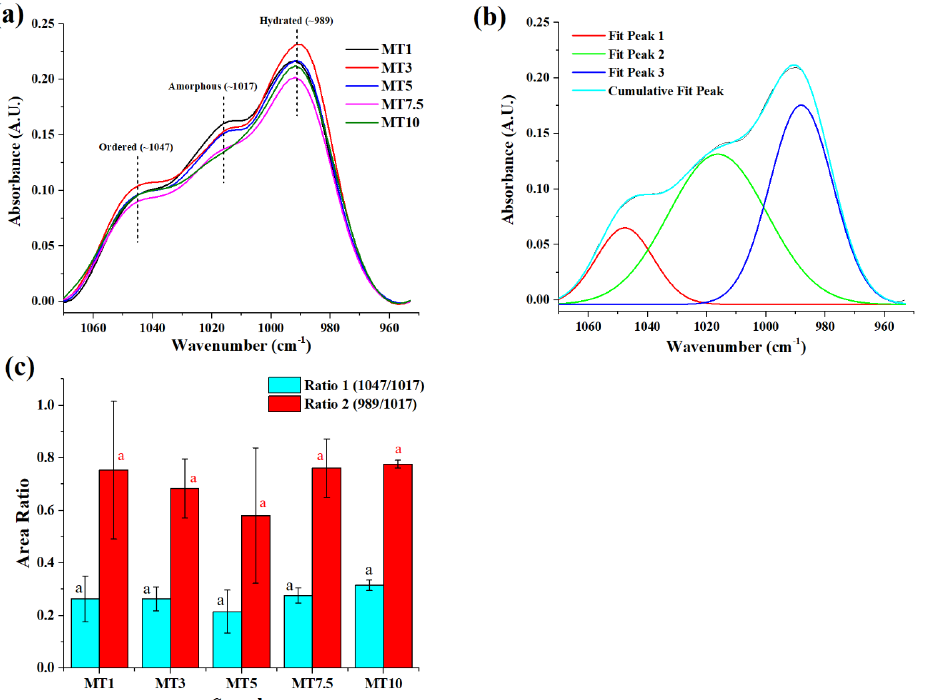
Figure 8. Graphs showing ( a ) starch region in different samples, ( b ) a representative graph of deconvoluted starch region, and ( c ) variation of ratio obtained in the starch region concerning different samples. The alphabets above columns of the same color denote statistically significant ( p < 0.05) differences.